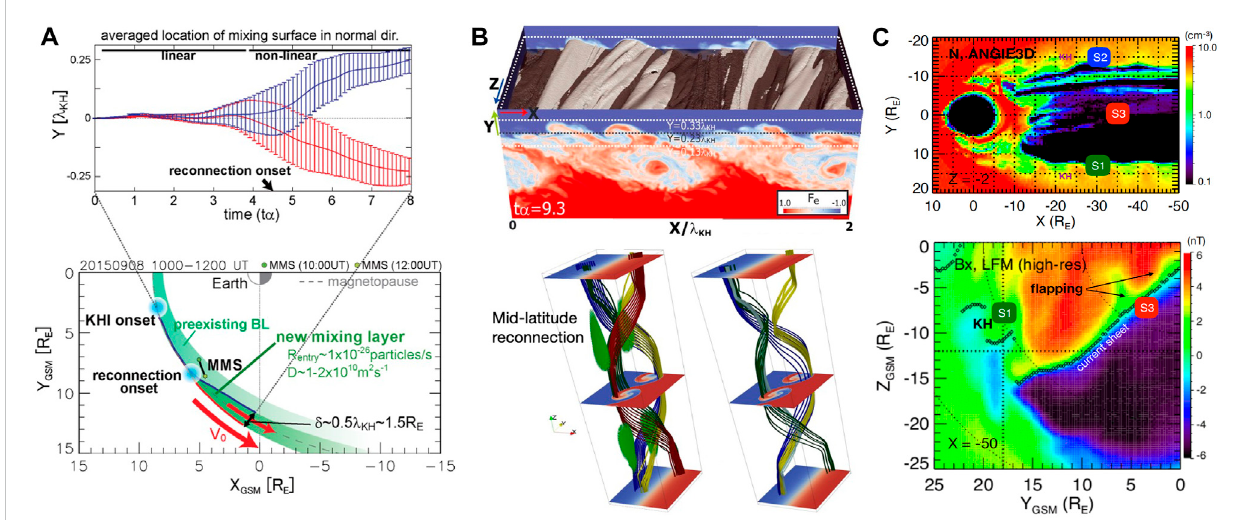
FIGURE 1 Solar wind plasma transport into the magnetosphere induced by KHWs via diffusive transport (A) upper: time evolution of the plasma mixing, lower: the locations of the mixing layer shown in the upper plot projected onto the modeled magnetopause together with particle entry rate and diffusion coef fi cient near the MMS location marked by the dumbell-like symbol). Vortex-induced “ in-plane ” reconnection occurs along the KHV boundary generating a series of fl ux ropes ( (B) , upper). KHVs also facilitate mid-latitude reconnection ( (B) , lower) north/south of the velocity shear plane near the equatorial region from Faganello et al. (2012). Illustration of KHWs externally driving current sheet fl uctuations as predicted in a global hybrid simulationusingANGIE3Dcode( (C) ,upperpanel;Linetal.,2014;Linetal.,2017)andglobalMHD(LFM)simulation(lowerpanel,Merkinetal.,2013).Under thedevelopment ofKHVs(markedbyS1andS2 intheupperpanel), inward-propagatingKHW-associated fl uctuationsdrive anorth-to-south asymmetry inthecentralcurrentsheet,whichcausescurrentsheet fl apping(S3; (C) ).Thisperturbationmayplayaroleinthemagnetotailreconnectiononsetorserve triggersofthemarginallystablecurrentsheet.TheKHWsare,inturn,affectedbythecurrentsheet fl appingthatoftenpropagatesfrommidnighttodawn/ dusk fl anks.SimultaneousobservationsoftheKHactivityatthedawn/dusk fl ankandthecurrentsheetthicknessandbehavioratalocationdeepinsidethe magnetopause provide an important causal relationship between the fl ank and midnight current sheet